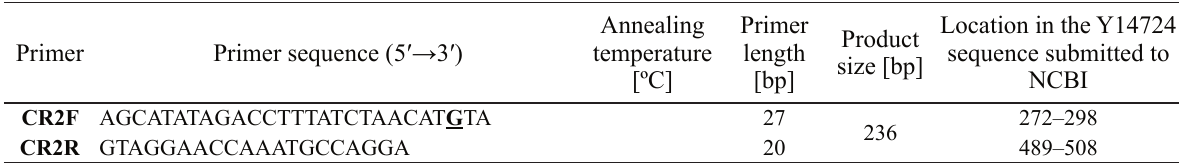
Primer sequence used in the amplification of the mtDNA control region by ACRS-PCR, with a marked change in the